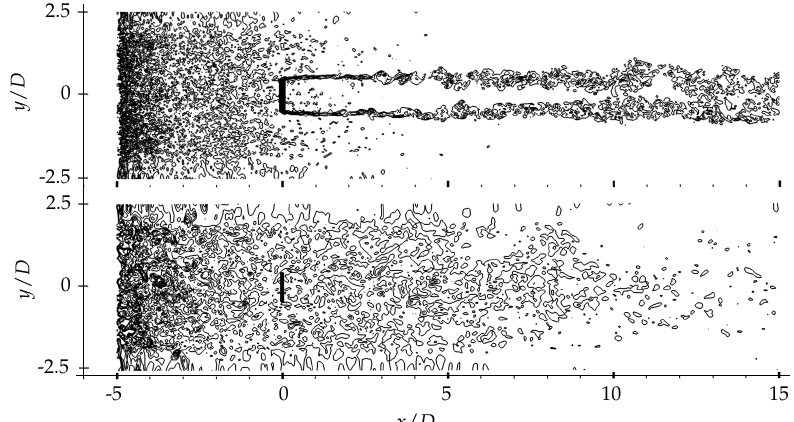
Figure 17. Contours of the vorticity field obtained with the Ti3 inflow and disk C T = 0.62 ( top ) and the Ti12 inflow and disk C T = 0.71 ( bottom